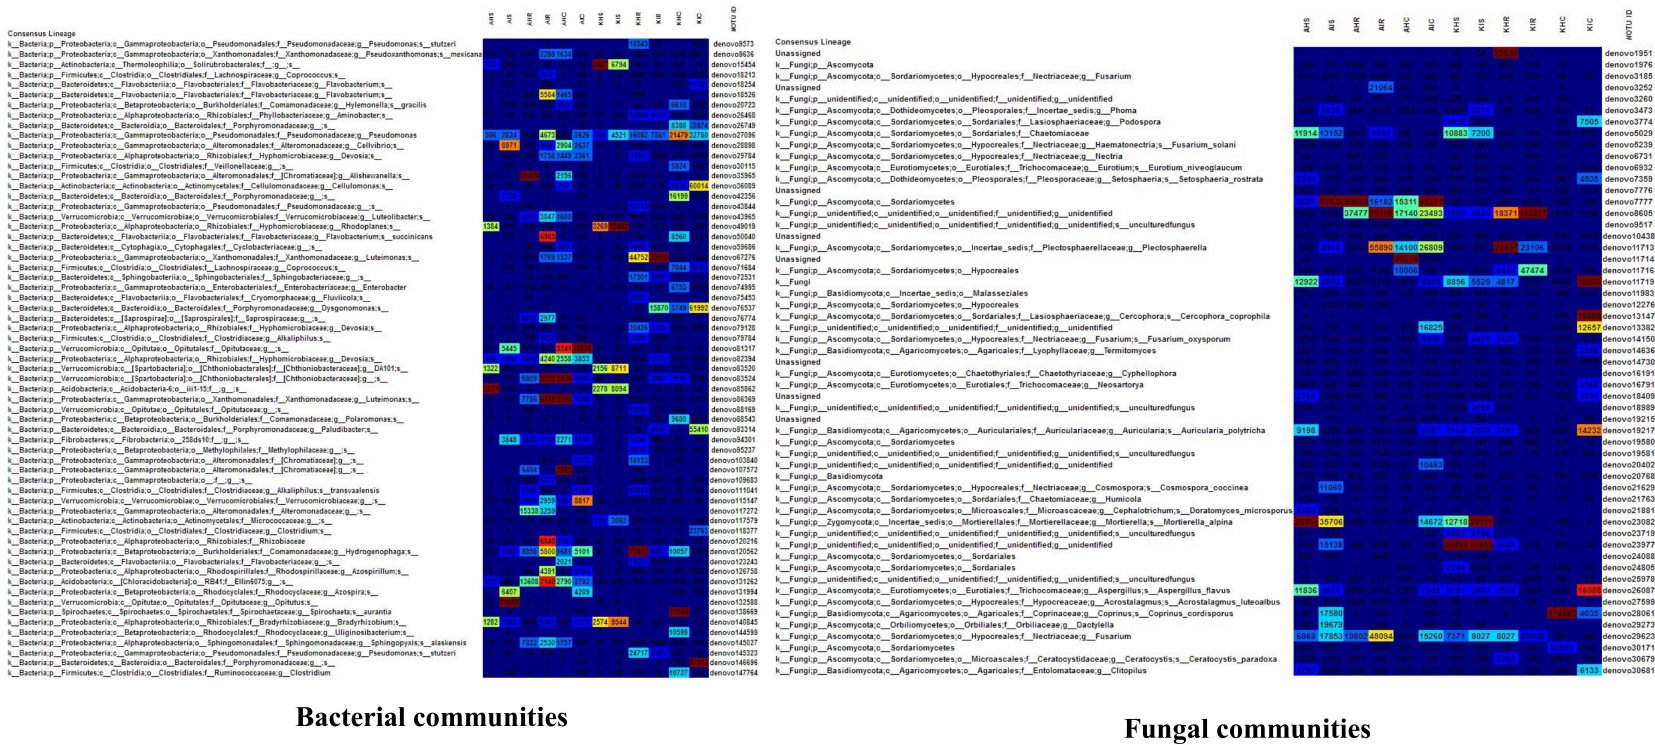
Figure 5. An OTU table heat map showing taxonomy assignment for each OTU from sample. The OTU heatmap displays OTU counts per sample, where the counts are colored based on the contribution of each OTU to the total OTU count present in the sample (blue: contributes low percentage of OTUs to sample; red: contributes high percentage of OTUs). The table based on taxonomy assignment is filtered the OTU table by number (10,000 for bacteria and 5,000 for fungi) of counts per OTU. A: Arusha; C: Corm; H: Asymptomatic; I: Symptomatic; K: Kilimanjaro; R: Roots; S: